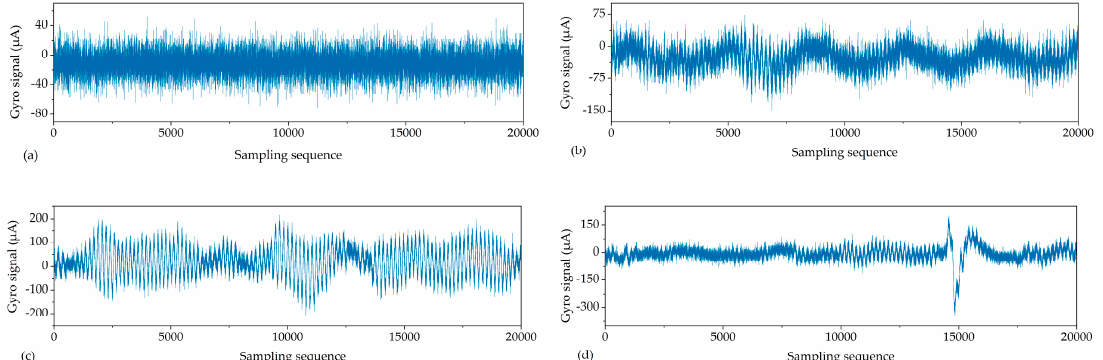
Sensors 2019 , x , x